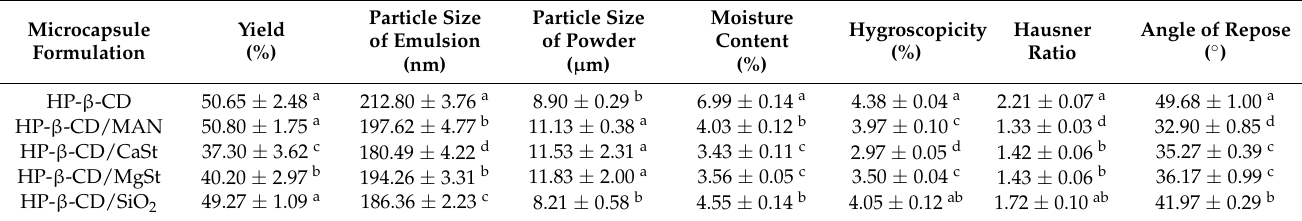
Table 1. Chemical properties of microcapsules with different anticaking